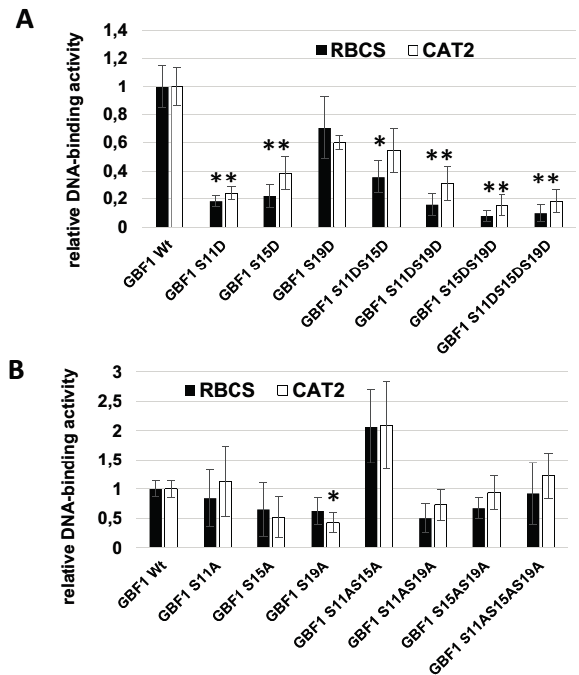
Figure 3. DPI-ELISA using recombinant GBF1 and single, double, and triple mutants of the serines in the basic domain with the G-boxes of the CAT2 and the RBCS1a promoter. Biotinylated plate coupled DNA fragments containing the G-box of the RBCS1a promoter (black bars) or of the CAT2 promoter (white bars) were incubated with crude E. coli BL21 extracts expressing recombinant 6×His-tagged GBF1 or GBF1 with substituted serines of the basic domain. The amounts of recombinant protein in the raw lysates were quantified on a Western blot using ImageQuantTL software, and DNA-binding was normalized to the protein amounts. The interactions between 50-fold diluted crude extracts and the wild type GBF1 was set to 1.0, all other interaction are expressed as relative values referring to GBF1/G-Box. ( A ) Consecutive substitution of serines at position − 11, − 15, and − 19 with aspartate (D); ( B ) consecutive substitution of serines (S) at position − 11, − 15, and − 19